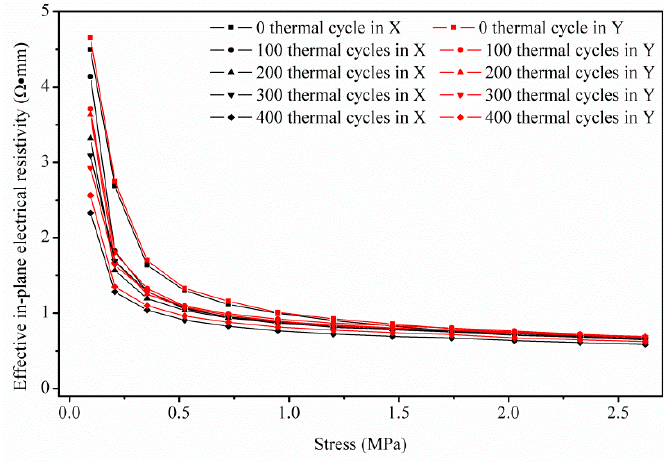
Figure 8. Effective in ‐ plane electrical resistance vs. stress curves of pristine and aged GDLs.